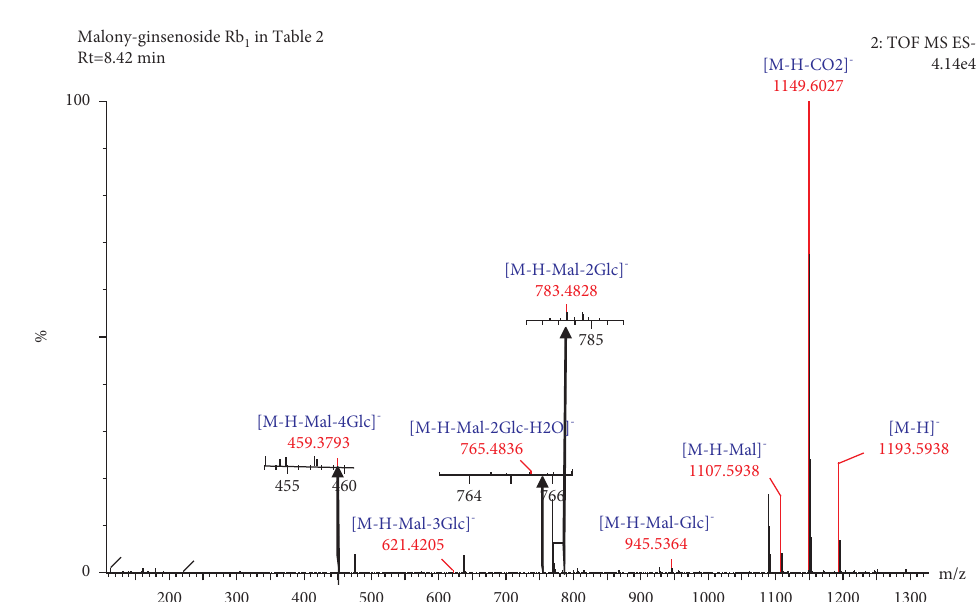
Figure 4: Secondary mass spectrogram of malonyl-ginsenoside Rb